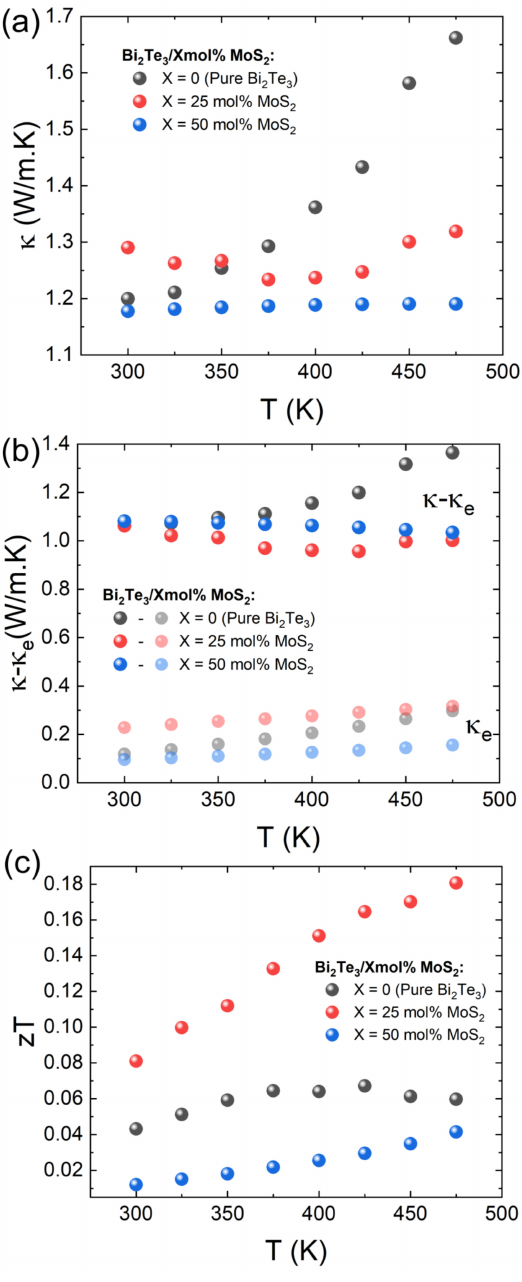
Figure 4. Temperature dependence of ( a ) total thermal conductivity κ ; ( b ) κ - κ e ; and ( c ) ZT of Bi 2 Te 3 /X mol%MoS 2